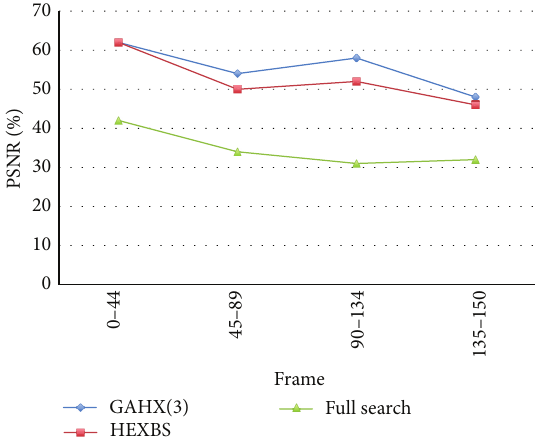
Figure23:AveragepercentrateperframeofPSNRworsethan30 dB compared with various schemes for Bus video sequence.